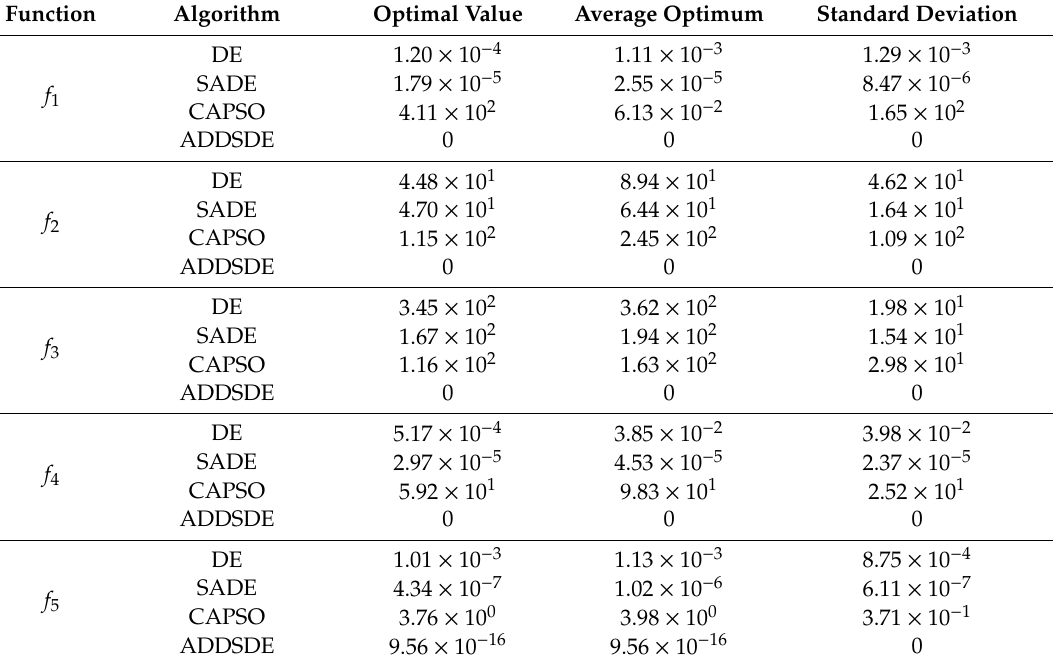
Table 3. 50-dimensional function optimization